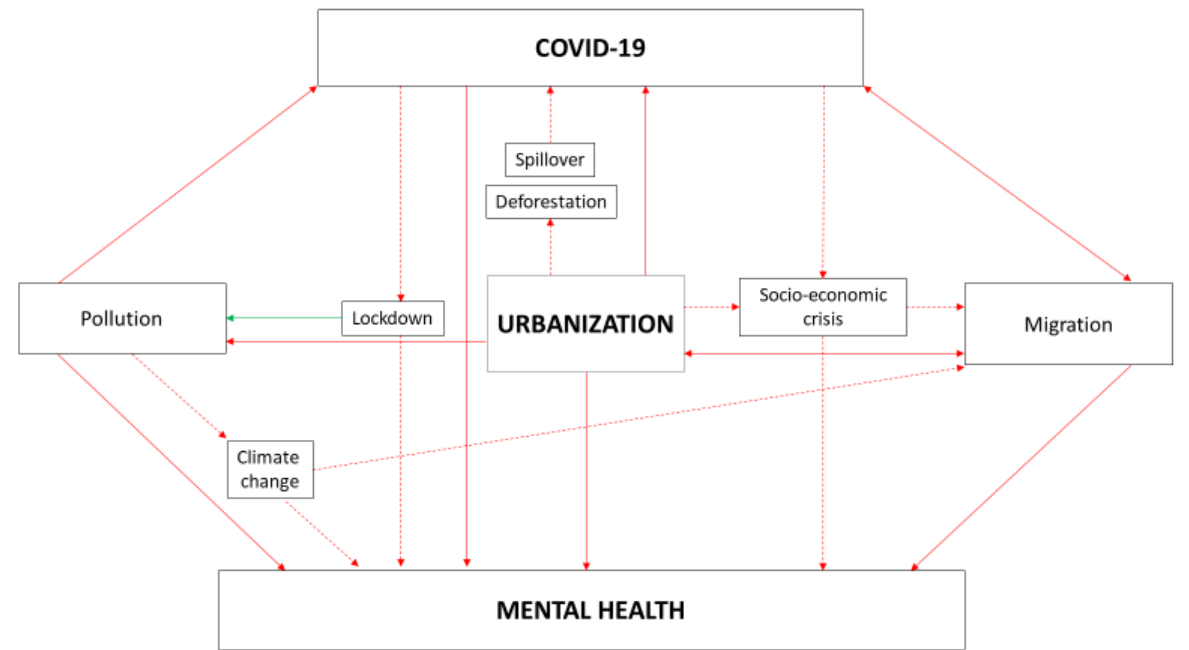
Figure 1. Possible causal relationships between COVID-19, mental health and urbanization.